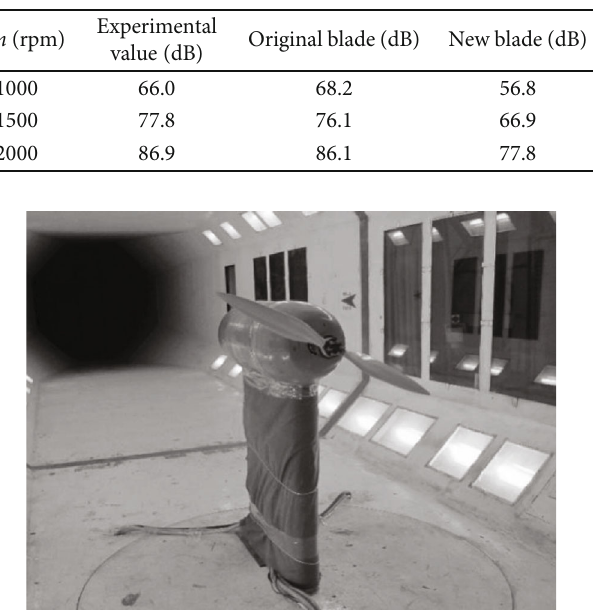
Table 4: The sound pressure value of the propeller at corresponding speed.